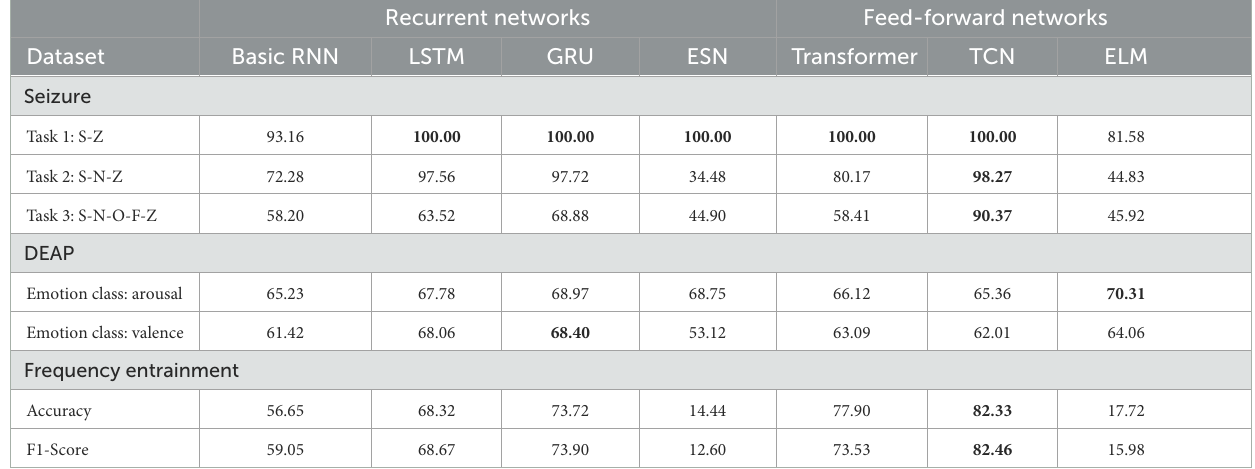
TABLE 5 Accuracy (%) of different neural network topologies for multiple EEG datasets.